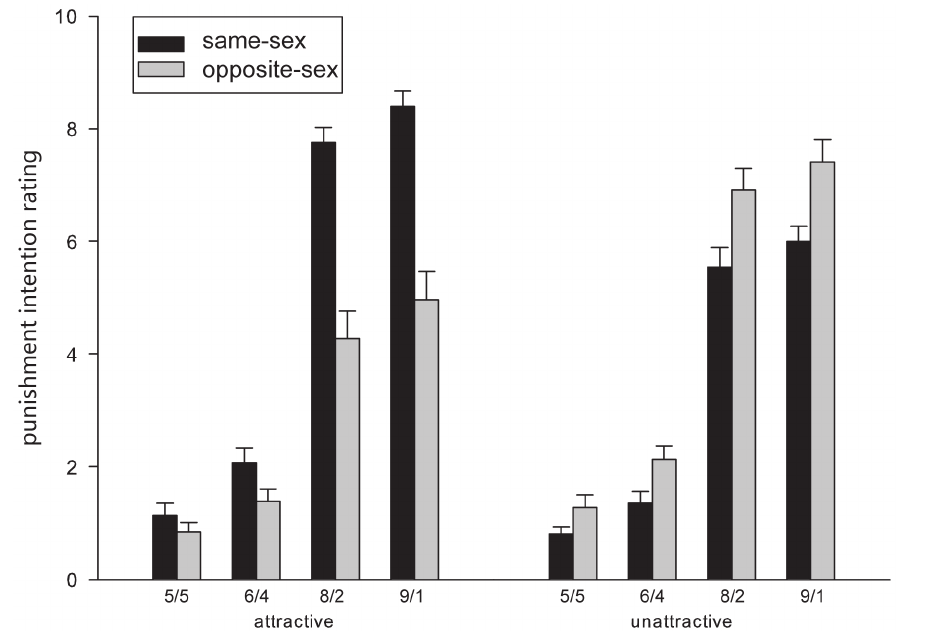
Figure 2. Mean scores for participants’ intention to punish attractive and less attractive proposers as a function of the reasonableness of offer and sex congruence between the proposers and the participants. 5/5 = equal division of 100 yuan between the proposer and the recipient; 6/4 = the proposer received 60 yuan while the recipient received 40 yuan; 8/2 = the proposer received 80 yuan while the recipient received 20 yuan; and 9/1 = the proposer received 90 yuan while the recipient received 10 yuan. Error bars represent standard errors.